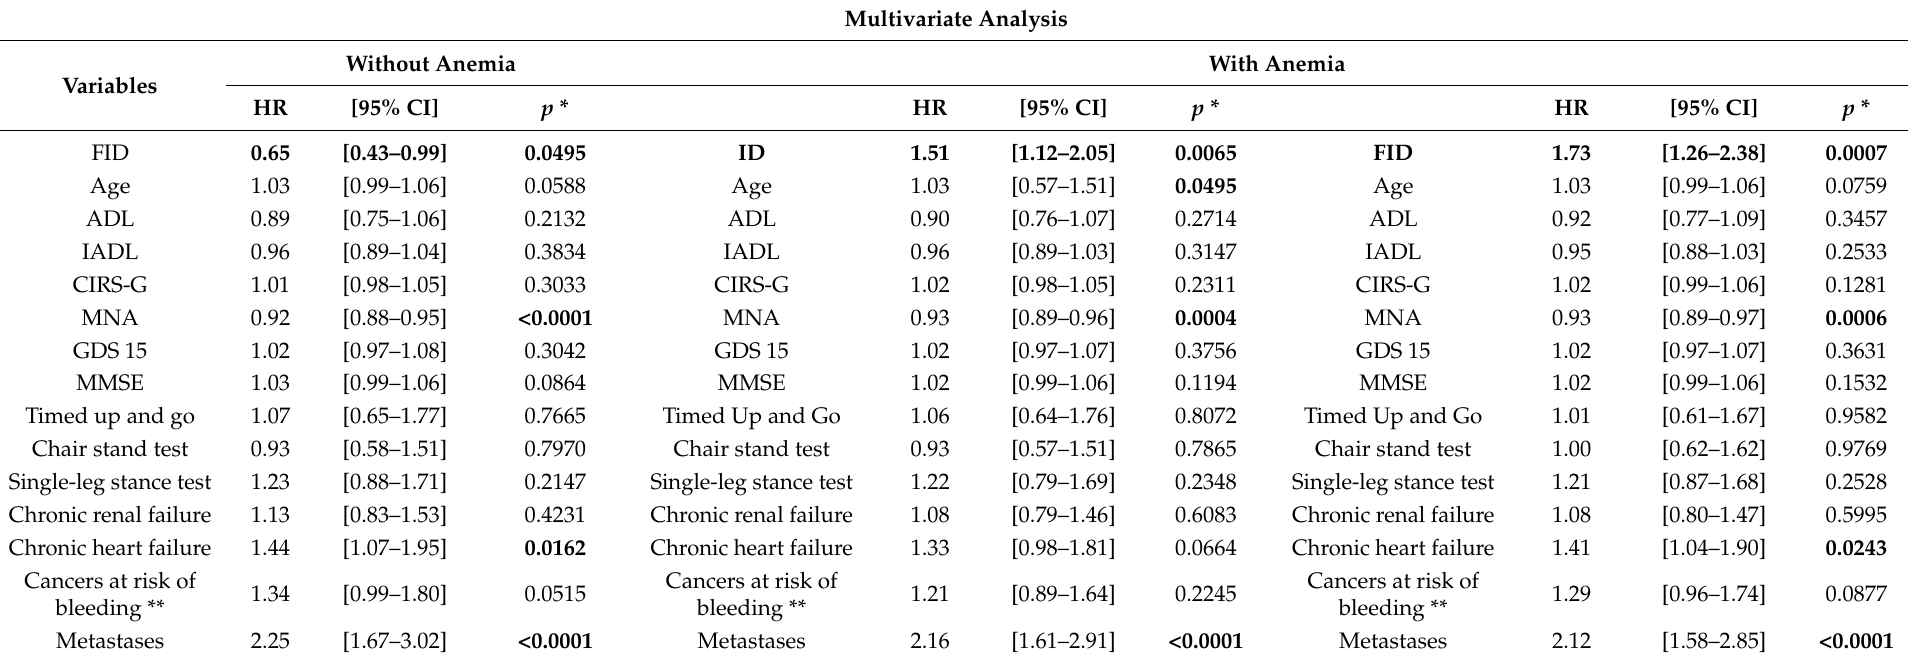
Table 4. Iron status in relation to overall survival in multivariate